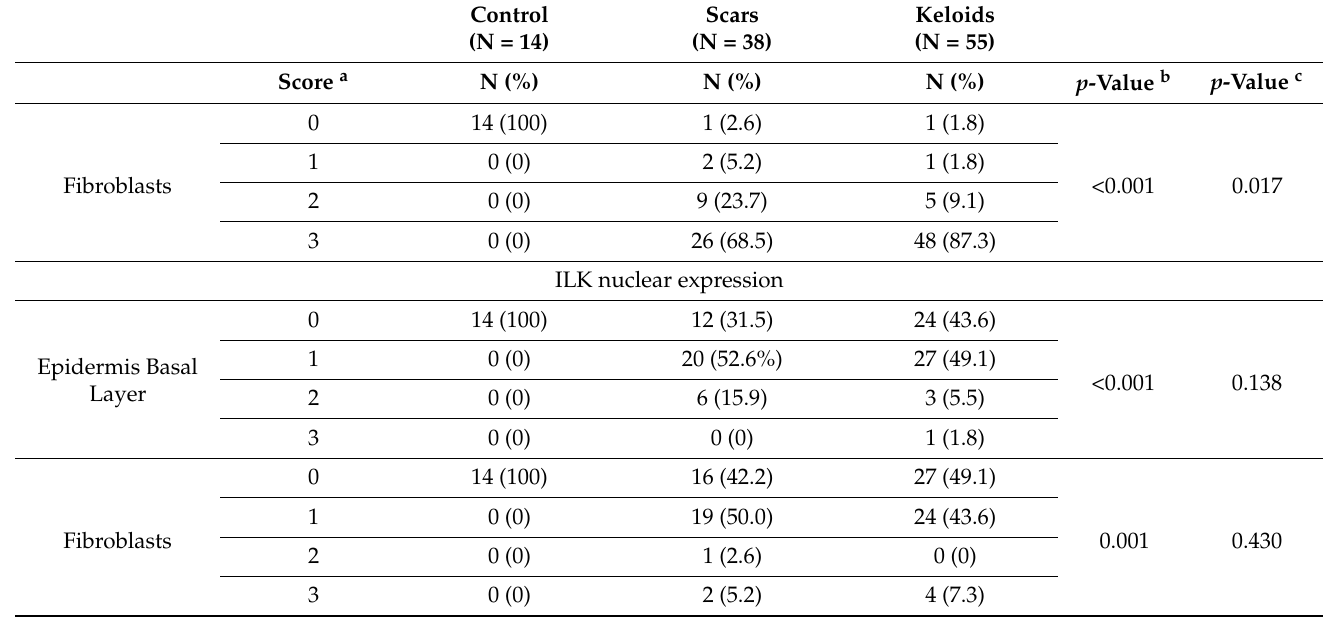
Figure 3. Plots depicting the correlation between ILK and expression of YAP, TAZ and TEAD4 in fibroblasts. 4. Discussion Deregulation of the normal wound-healing processes accounts for skin scarring and keloid formation that is characterized by an increased number of fibroblasts and the ex- cessive deposition of extracellular matrix (ECM) in the dermis [23]. In this study, we pro- vide novel evidence implicating Hippo pathway deregulation and ILK overexpression in the formation of keloids and hypertrophic scars.